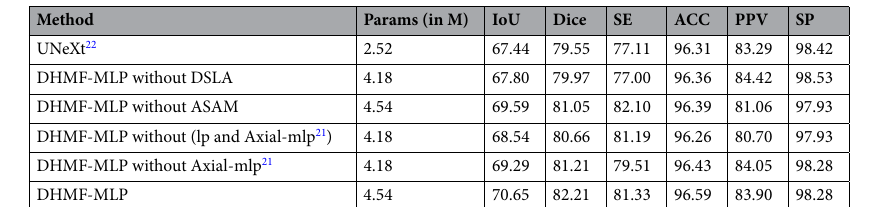
Table 4. Ablation studies of the proposed blocks on the BUSI